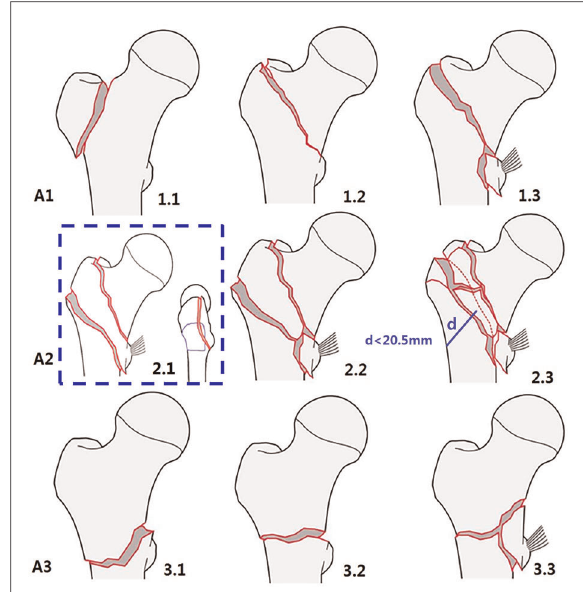
FIGURE 2 AO/OTA fracture classi fi cation of proximal femur trochanteric region 31A, 2018 version. In the blue dotted frame, the original blank of A2.1 was fi lled with a large banana-like posterior coronal fragment that constitutes the posterior greater trochanter, crest, and lesser trochanter with/without the posteromedial cortex